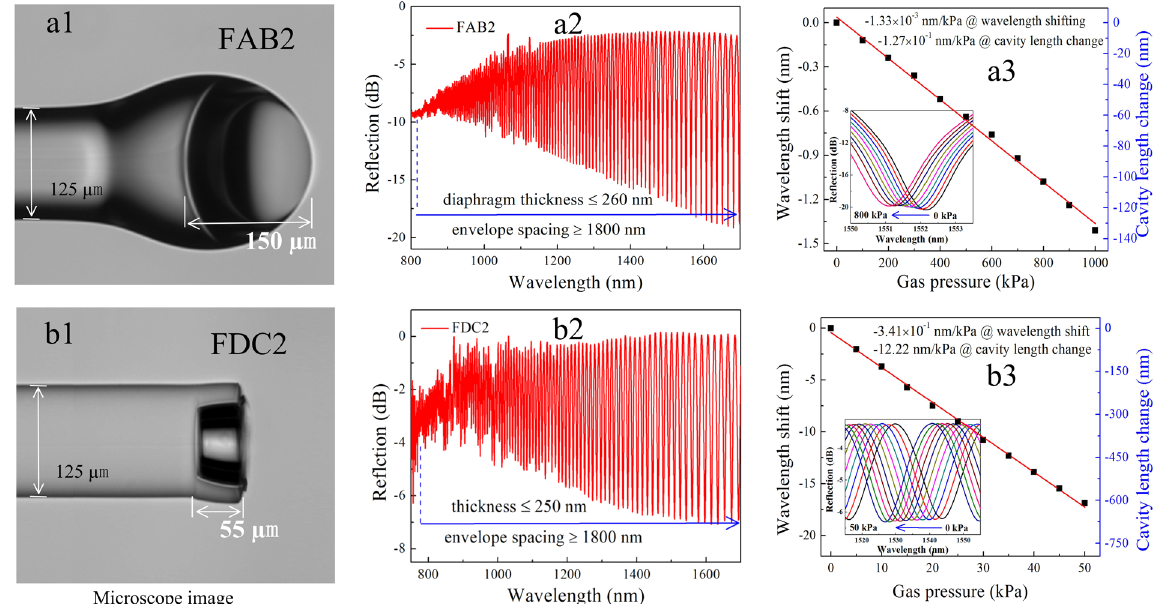
Figure 5. Sensor specimens based on an optimized sensing diaphragm. ( a1 ) Optical microscopy image of specimen FAB2 with a cavity length of about 155 µ m and a diaphragm thickness of about 290 nm. ( a2 ) The reflection spectrum of FAB2. ( a3 ) Wavelength shift of the interference fringe around 1530 nm with the gas pressure varying from 0 to 1.0 MPa, and the slope of the linear fitting is about 1.33 × 10 − 3 nm/kPa, reflecting a corresponding gas pressure sensitivity of about 1.27 × 10 − 1 nm/kPa. The inset presents the reflection spectral evolution. ( b1 ) Optical microscopy image of specimen FDC2 employing an FDC with a cavity length of about 55 µ m and a diaphragm thickness of about 250 nm. ( b2 ) The reflection spectrum of FDC2. ( b3 ) Wavelength shift of the interference fringe around 1530 nm with the pressure varying from 0 to 50 kPa, and the corresponding gas pressure sensitivity based on the slope of the linear fitting is about 12.22 nm/kPa. The inset presents the reflection spectral evolution.